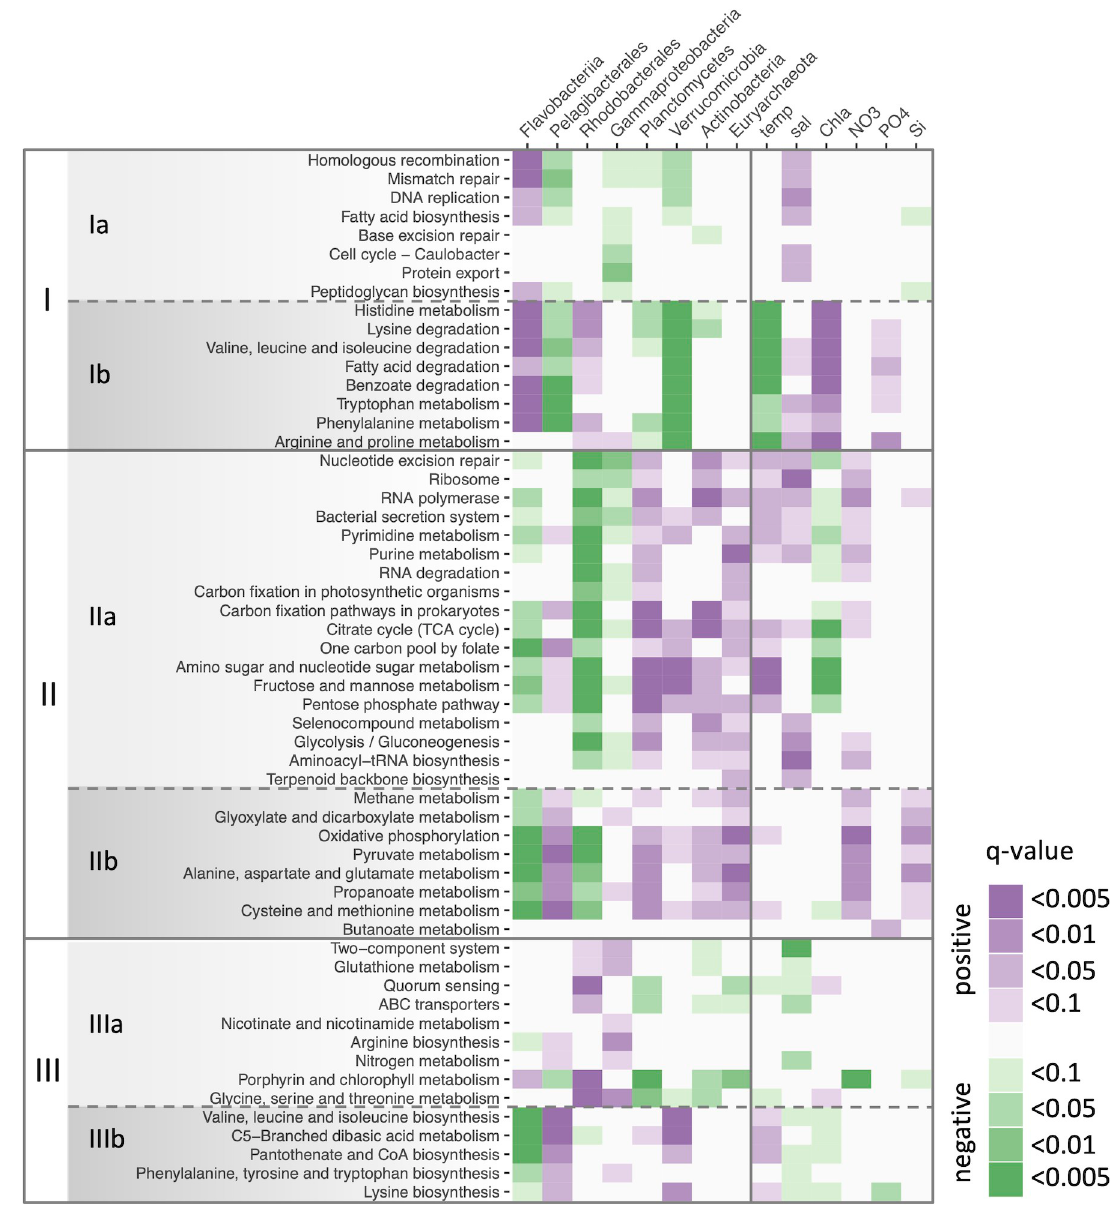
Fig 6. Significance of Spearman’s correlations between KEGG pathways and taxonomic groups or environmental variables. The KEGG pathways are arranged in the same order as in Fig 5.